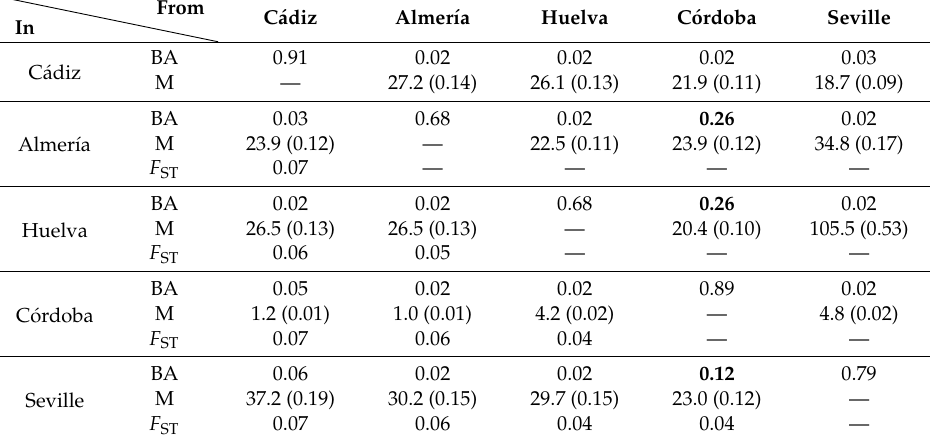
Table 3. Migration rates estimated as proportion of migrants in population from BayesAss (BA) and estimated as number of migrants per generation ( N m ) from Migrate-N (M) with estimated migration rate in parentheses. Rates in bold significant at p = 0.05. Pairwise F ST shown in lower diagonal. In